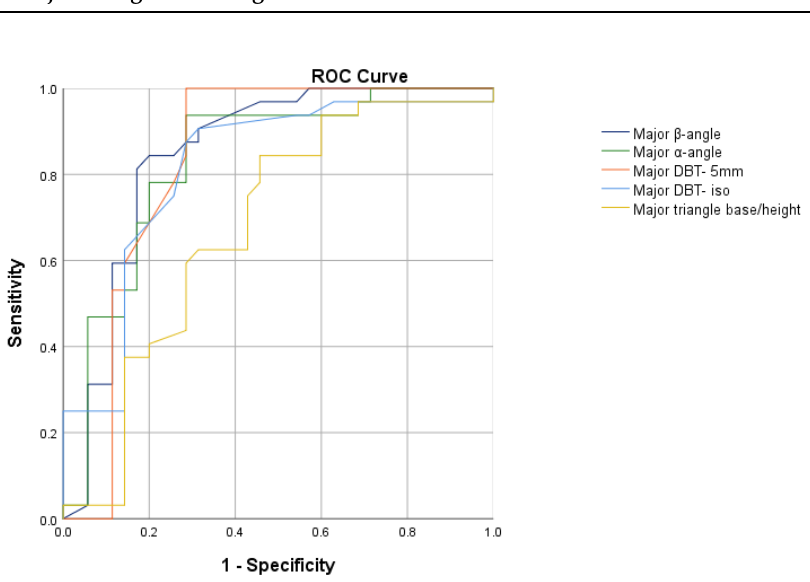
Figure 2. Receiver operating characteristic analyses of β -angle, α -angle, DBT- 5 mm, DBT- iso, and triangle base/height ratio to identify a BrS diagnosis after Sodium Channel Blocker Provocation Test in the test cohort.